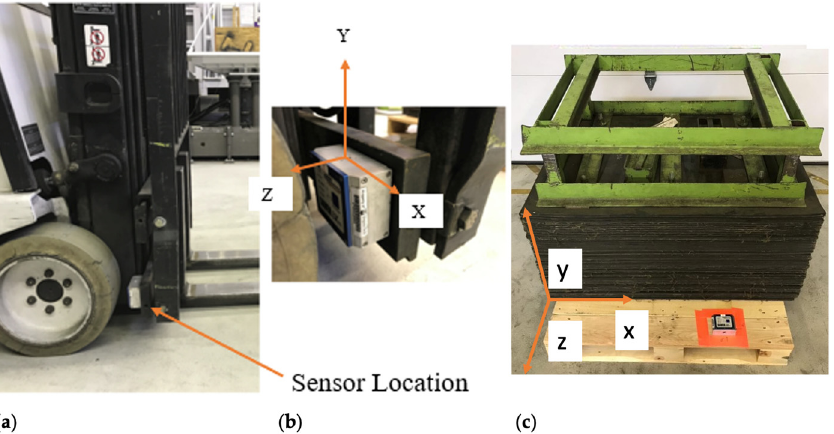
Figure 3. Representative picture of: ( a ): sensor location; ( b ) sensor orientation on the forklift; and ( c ) sensor location and orientation on the pallet.